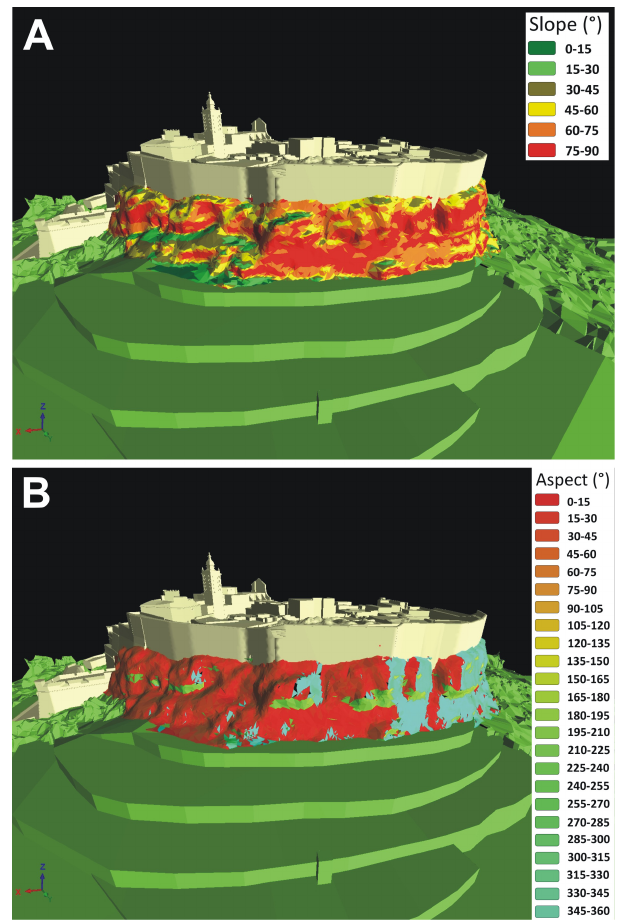
Fig. 12. 3-D maps of slope steepness (A) and aspect (B) of the Citadel rock